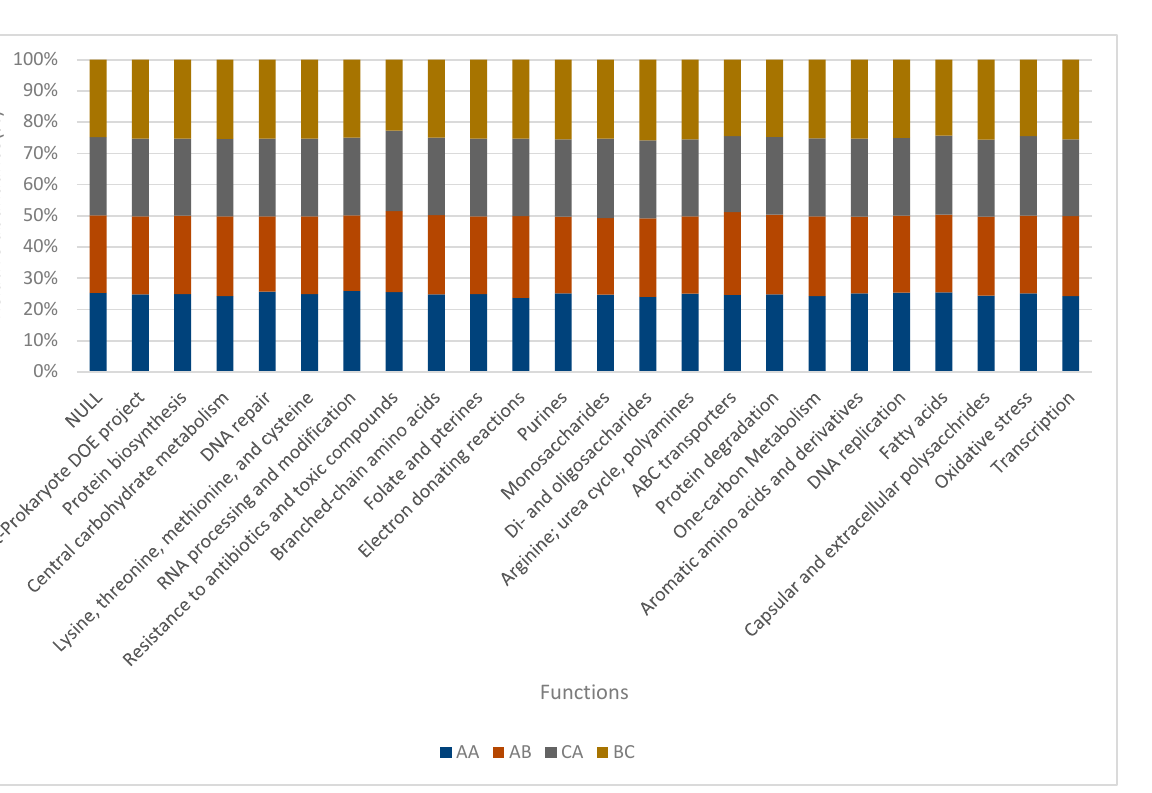
Figure 5. Bar-chart for selected functions in Level 2. AA, AB, and CA are rhizosphere soil samples while BC is a bulk soil sample.